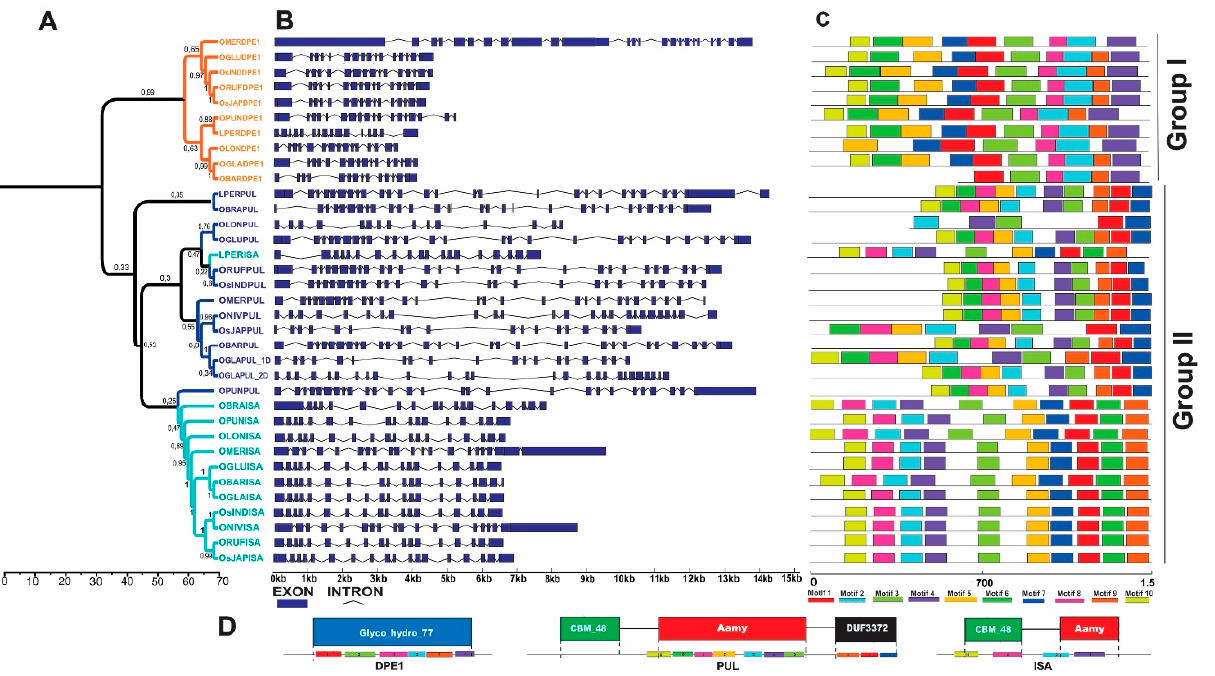
Figure 4. Phylogenetic relationship, genetic structure and conserved motifs/domain analysis in DBE genes of Oryza species. ( A ) Phylogenetic protein tree and bootstrap values of DPE1, PUL and ISA with branches marked in orange, blue and green, respectively. ( B ) Exon-intron structure of DBE genes in Oryza . ( C ) Arrangement of the 10 most frequent motifs found in the analyzed proteins. ( D ) Compositions and distributions of domain structures and conserved motifs of DBE proteins.